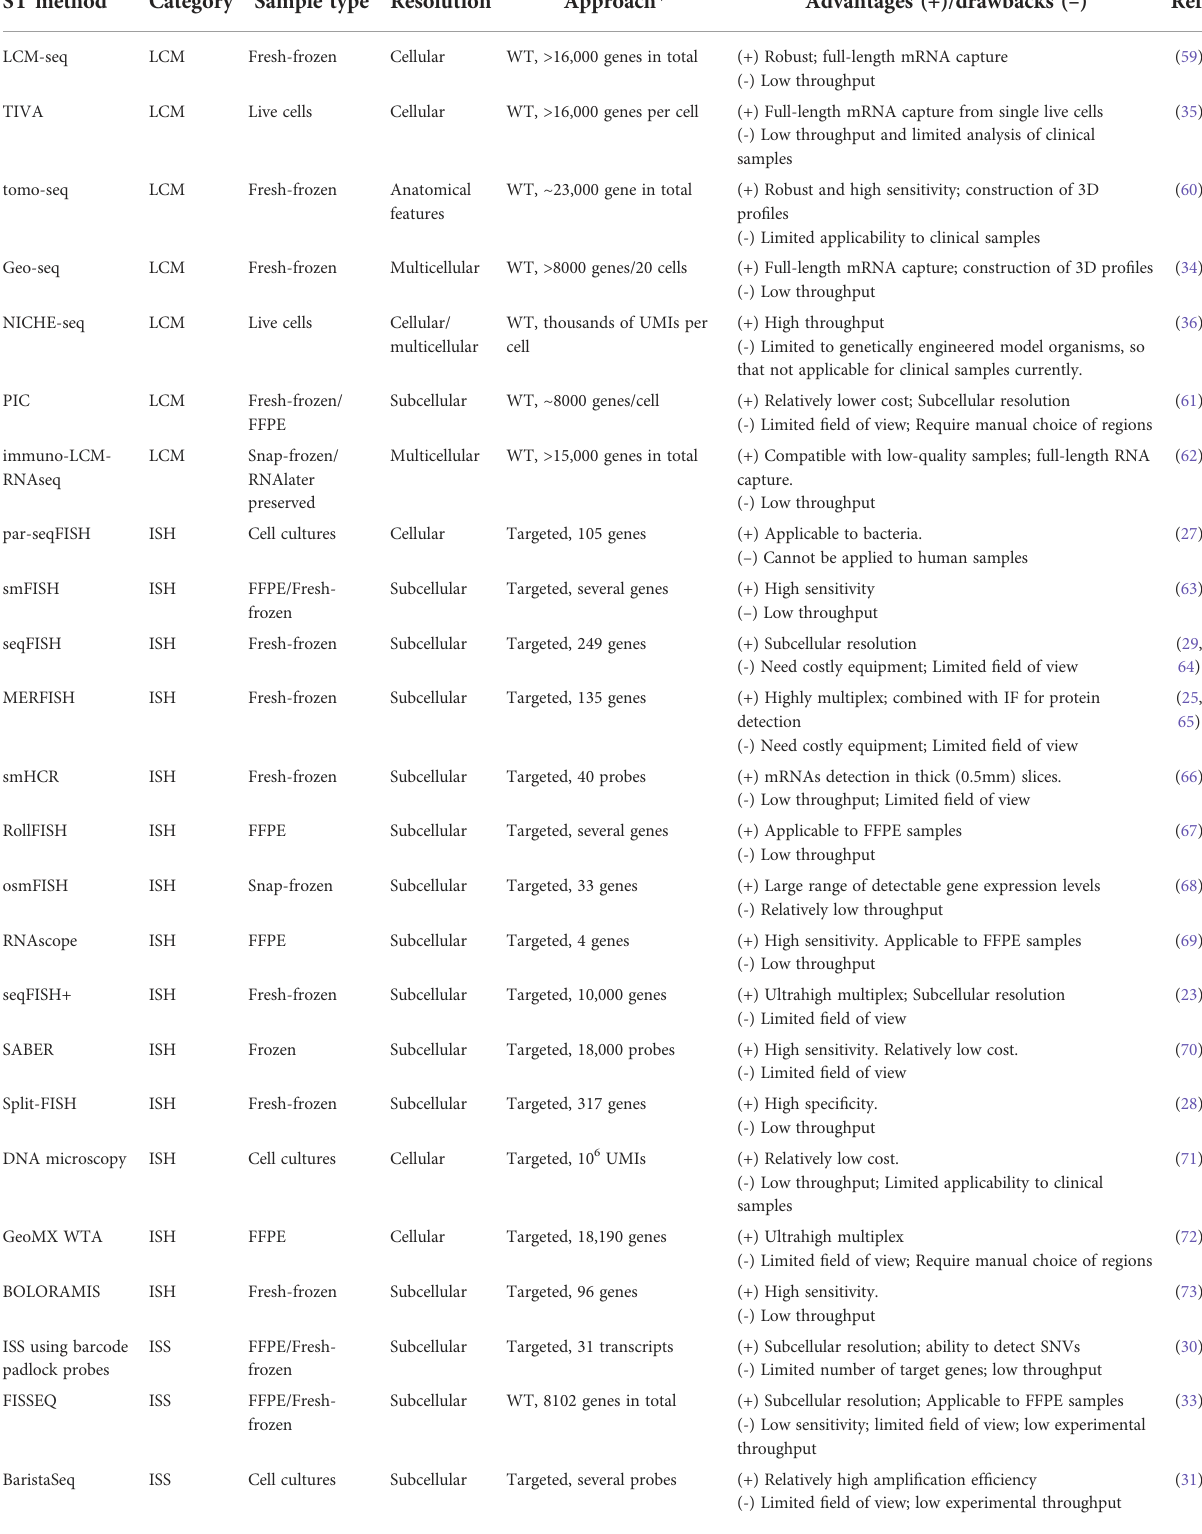
TABLE 1 Current ST